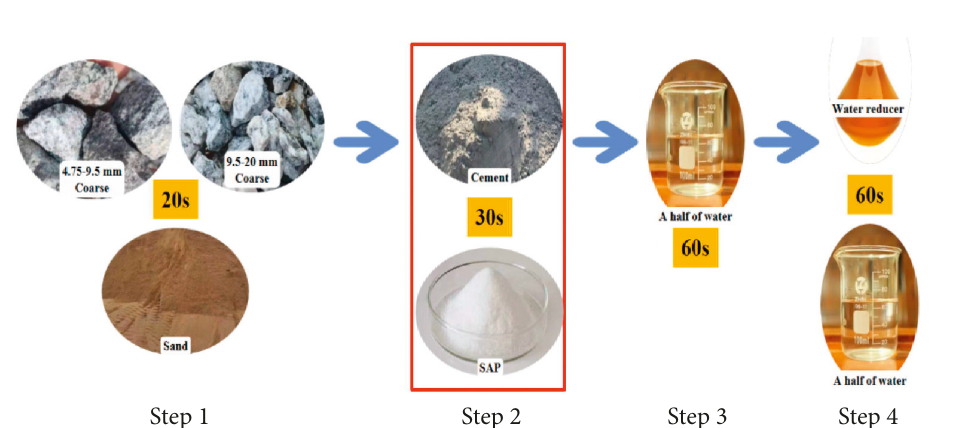
Figure 3: Preparing procedure of internal curing concrete with SAP.